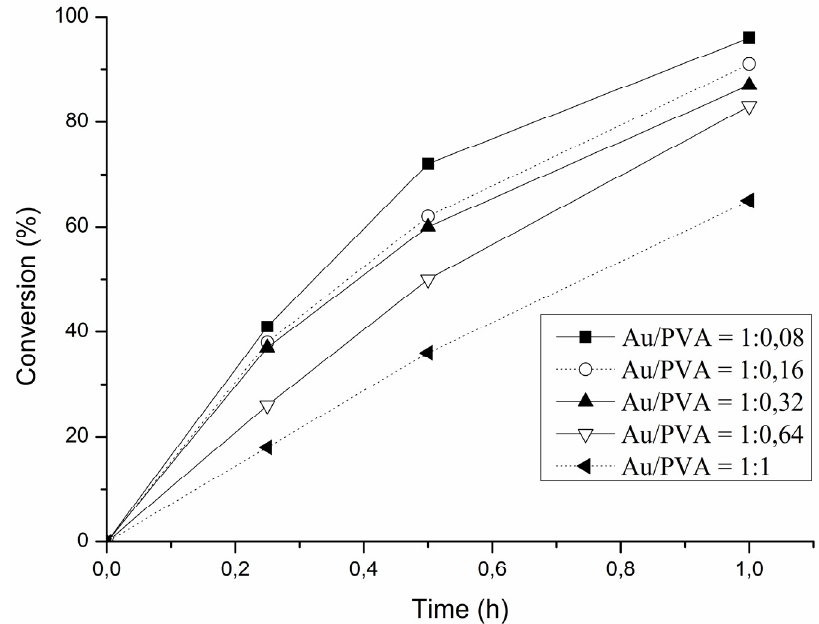
Figure 6. Catalytic activity of Au/AC by varying the Au/protective agent (PVA) weight ratio. Glycerol 0.3 M, NaOH 4 eq, Au/glycerol = 1/1000 mol/mol, p O T = 323 K.